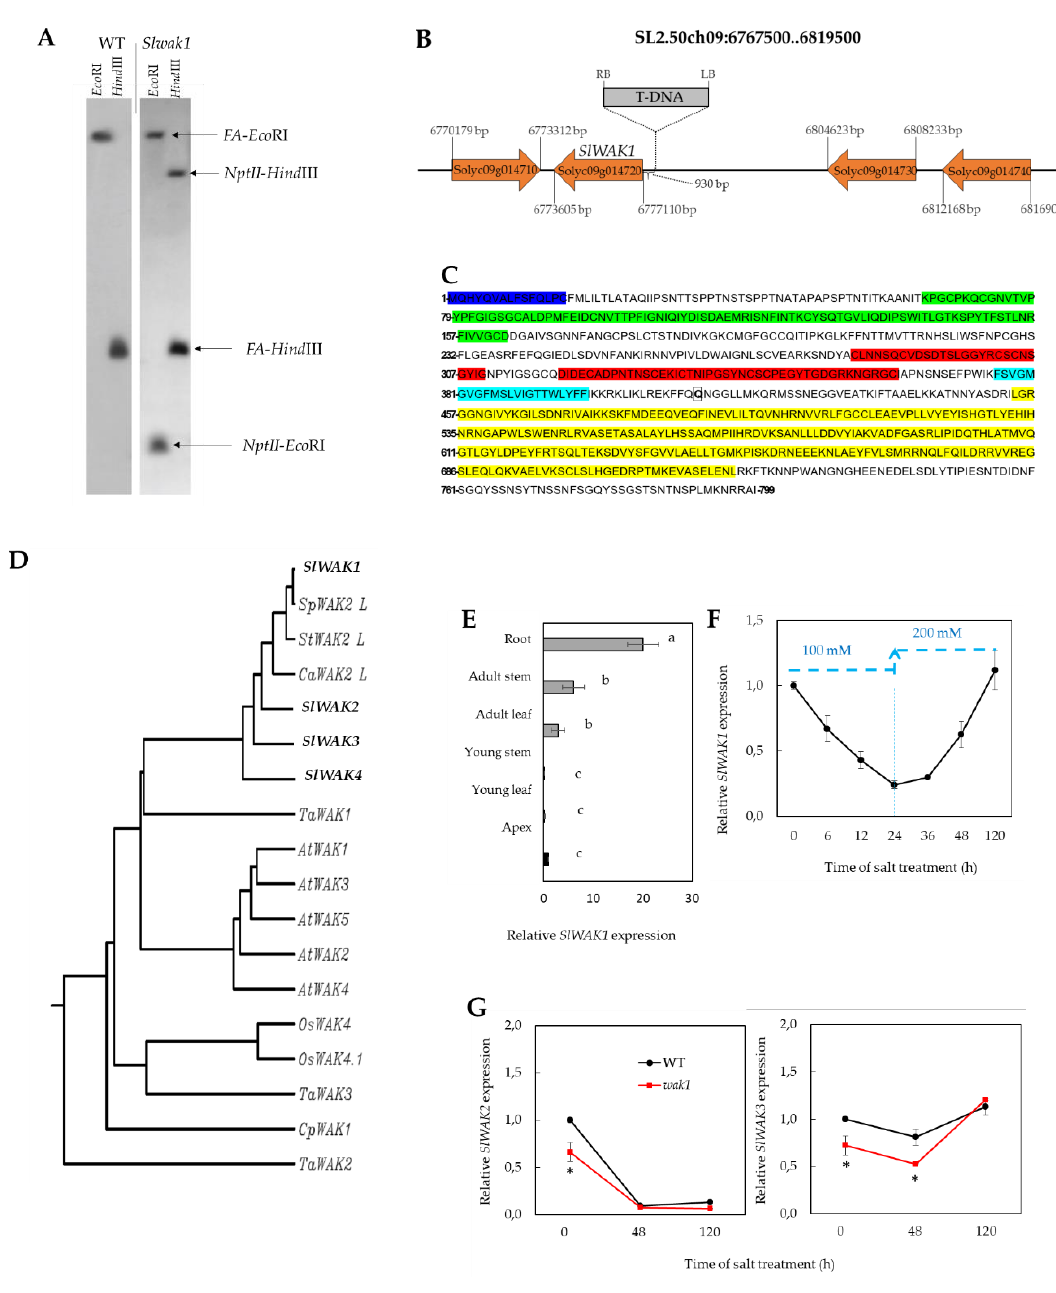
Figure 1. Identification of the knockout tomato mutant Slwak1 . ( A ) Southern blot analysis to determine the number of T-DNA insertions in Slwak1 mutant using a pool of T 2 plants with a chimeric probe that includes the complete coding sequence of the NptII gene fused to 811 pb of the coding sequence of FALSIFLORA ( FA ) (used as hybridization positive control). Single restriction fragments observed in genomic DNA digested with EcoRI and HindIII indicate the presence of a single T-DNA insertion in the Slwak1 genome. ( B ) Genomic organization of the WAK cluster in the tomato chromosome 9, composed of four isogenes coding for WAK proteins, and localization of the T-DNA insertion. SlWAK1 gene is tagged by the T-DNA localized 930 bp upstream of the coding region, most probably in the promoter region of this gene. ( C ) Amino acid sequence predicted from the SlWAK1 gene coding sequence, with predicted conserved protein domains, N-terminal signal peptide and transmembrane region highlighted, identified by making use of diverse bioinformatics tools (see Materials and